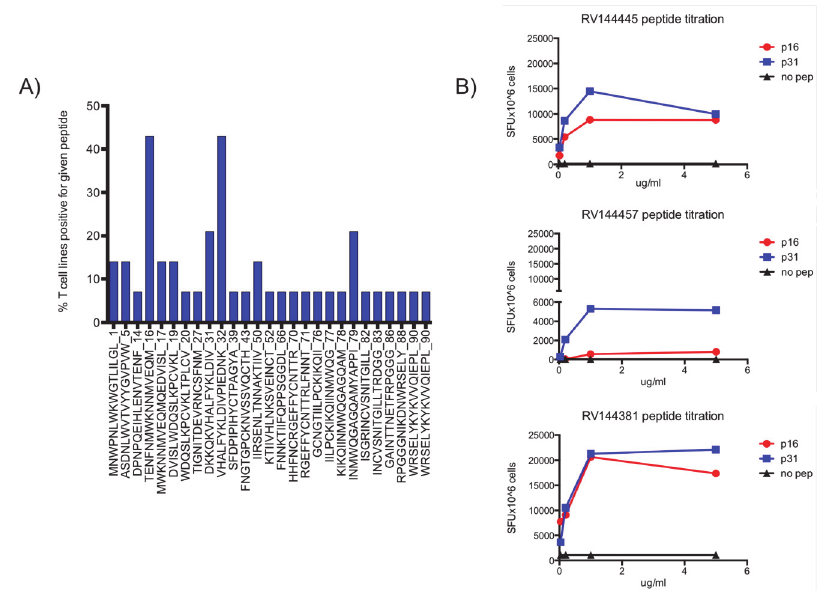
Figure 1. Envelope specific CD4+ T cell responses in RV144 vaccine volunteers. A) Graphical representation of the percentage of gp120A244 specific CD4+ T cell lines (N = 14) generated from RV144 volunteers that recognize a given peptide. The peptide sequence is showed on the X axis, number at the C- terminus is the sequential peptide number in the pool. B) Titration of the gp120A244 specific CD4+ T cell lines peptide responses. Three T cell lines responding to pep16 and pep31 are shown. Responses were measured in a modified ELISpot assay. Peptide concentration is shown on the X axes.